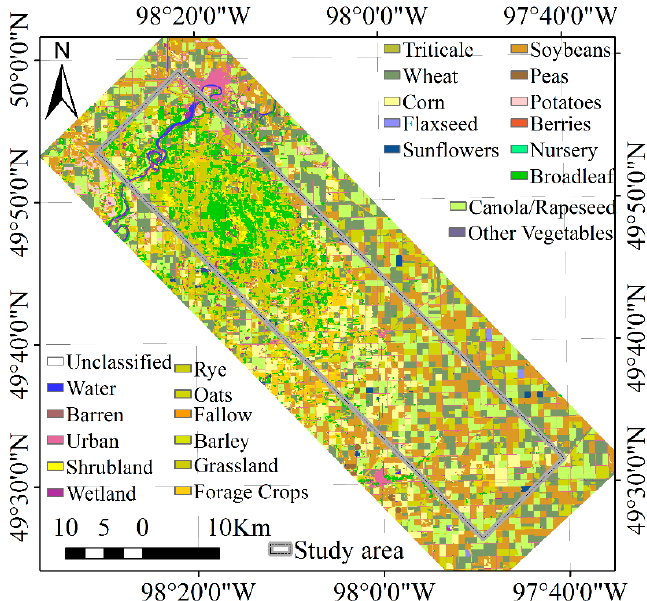
Figure 1. Spatial locations and land cover types of the study area in SMAPVEX12 .